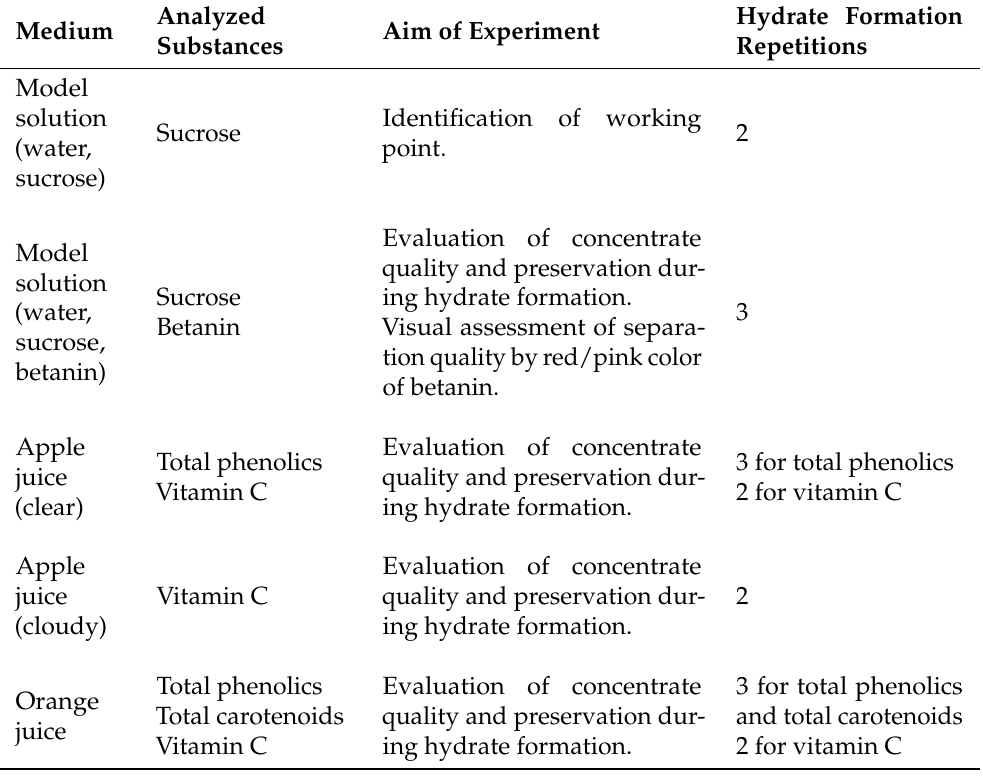
Table 1. An overview of the media used, indicating the substances considered, the experimental target, and the experimental repetition.